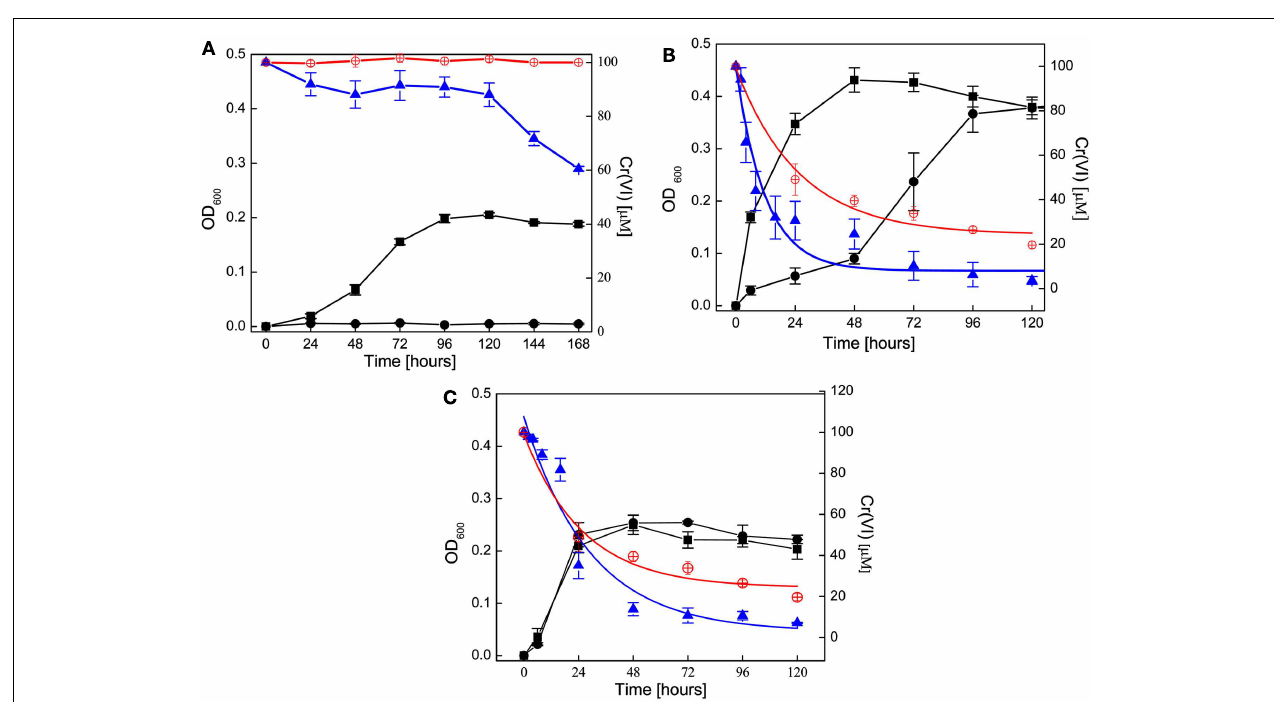
• (A) [FWA-NO 3 medium (B,C) , in SES3 medium without inoculum] is shown as ) as ( ⊕ ).The rate of change in Cr(VI) concentration was computed by fitting with an exponential function, and the fitted curves are shown in (B,C) as spline traces. Detailed parameters are tabulated in the text. In each panel, the left axis represent the OD and chromate concentrations are shown on right